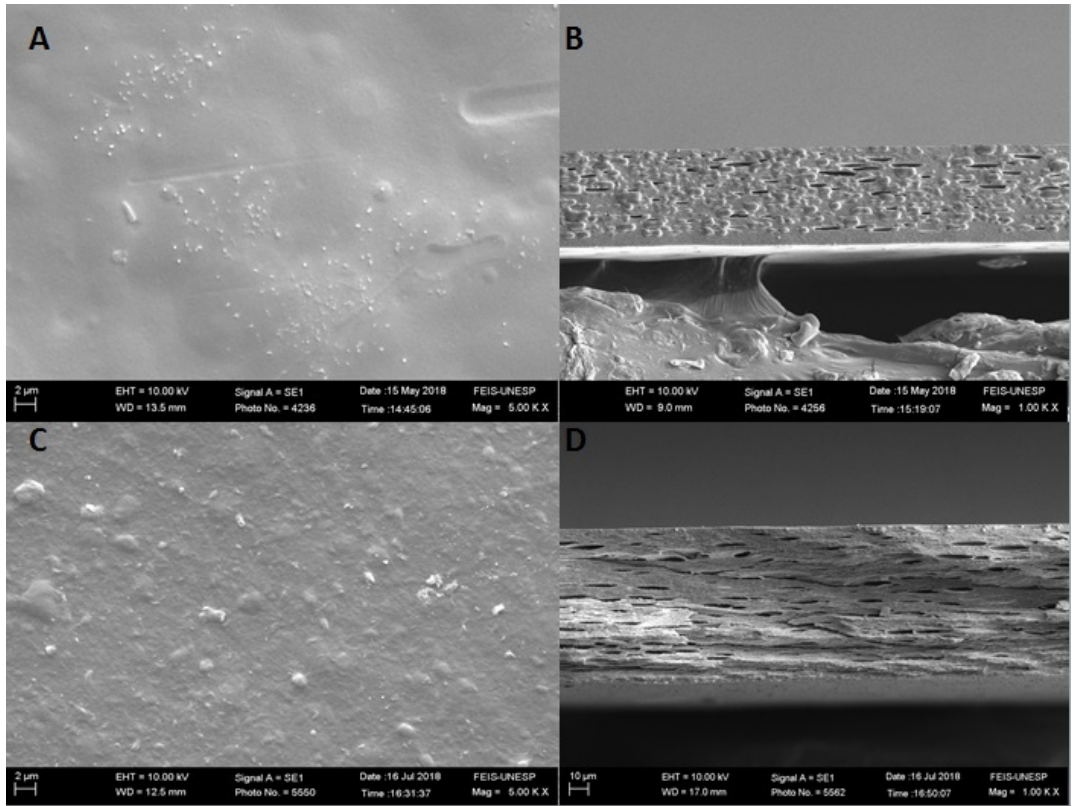
Figure 3. Scanning electron microscopy images of the films’ surfaces, ( A )–GEP4 film, ( C )–GEP4DA film; cryogenic fractures, ( B )–GE P4 film, and ( D )–GE P4DA film.